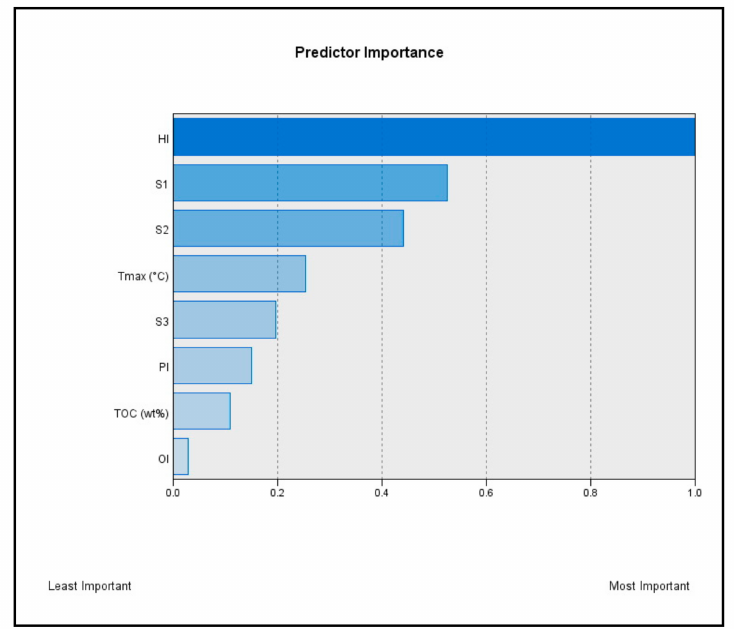
Figure 10. Predictor importance according to the TwoStep clustering